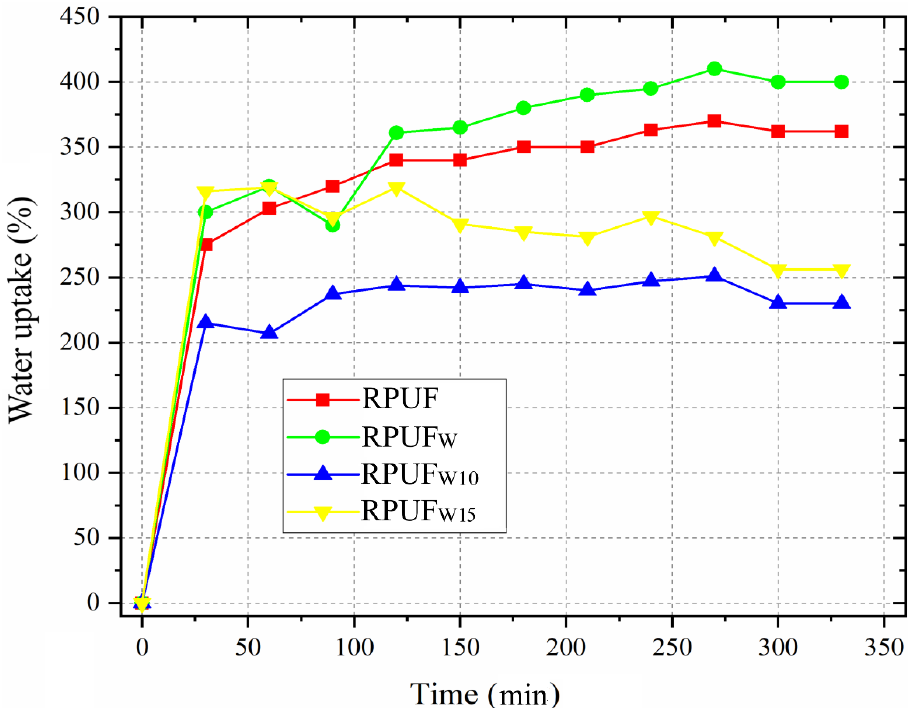
Figure 8. Water uptake of the studied fillers and RPUFs.